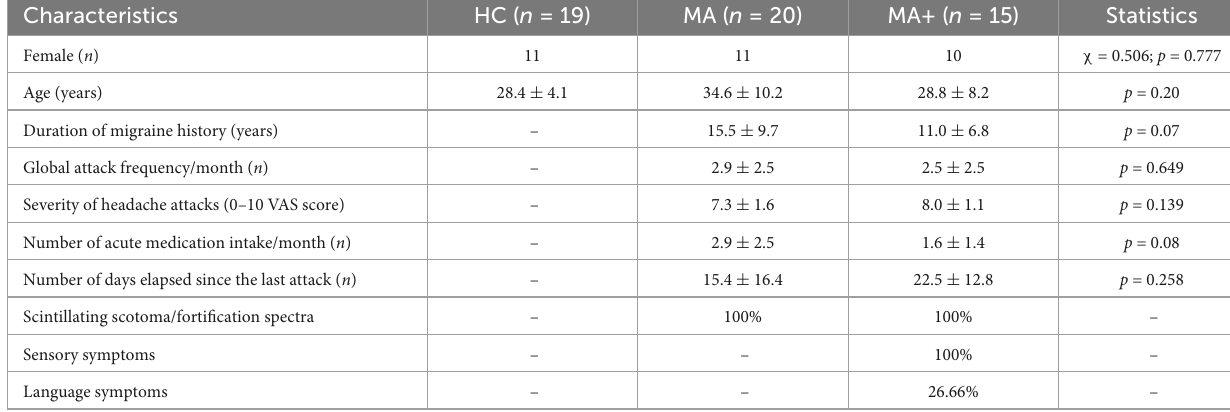
TABLE 1 Clinical and demographic characteristics of healthy controls (HC), migraine with exclusively visual aura (MA) patients and migraine with complex neurological aura (MA+) patients scanned between attacks.